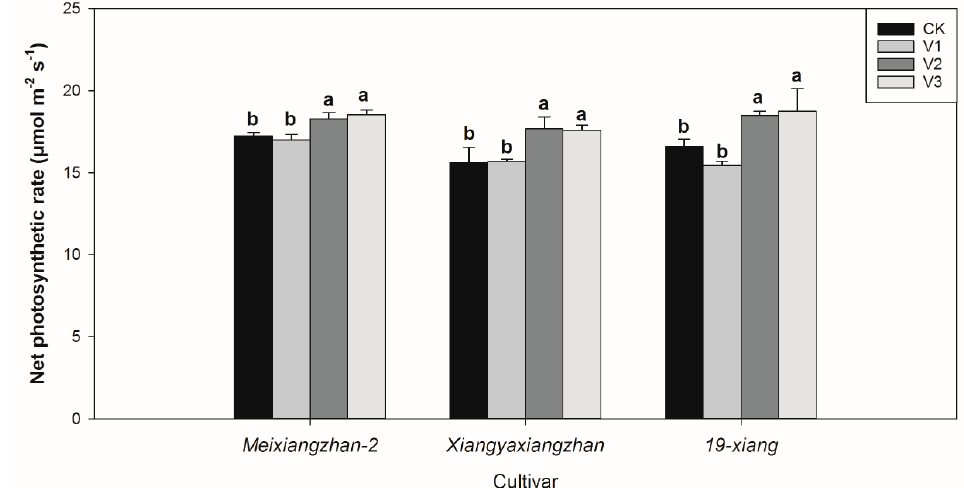
Figure 1. Effects of vermicompost incorporation on the net photosynthetic rate of fragrant rice seedlings; those sharing a common letter do not differ significantly at p < 0.05 according to the least significant difference (LSD) test for three fragrant rice cultivars.